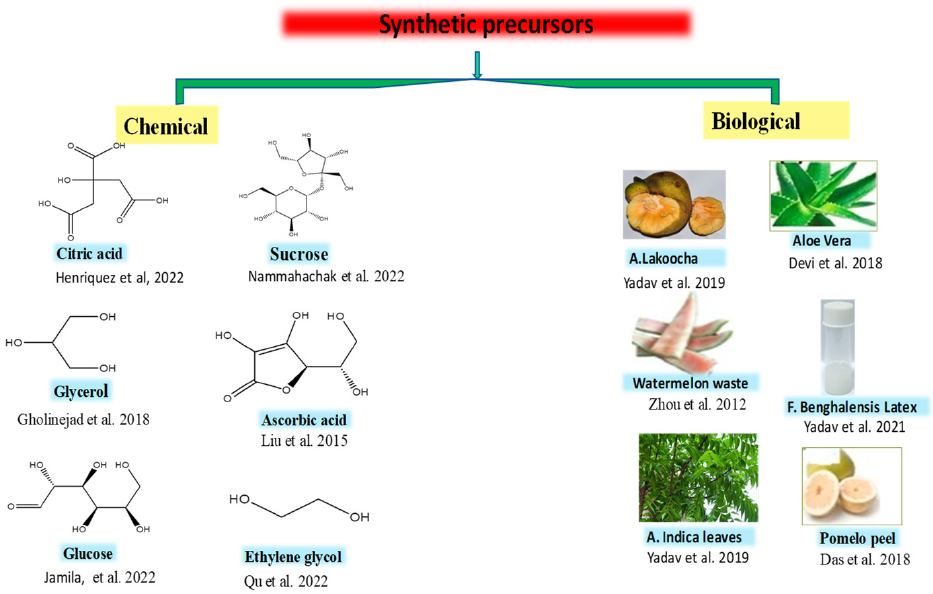
Figure 2. Chemical and biological precursors utilized for the synthesis of CQDs [61–72].